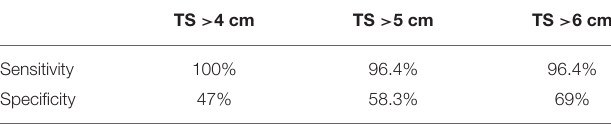
TABLE 4 | Sensitivity and specificity of different tumor size (TS) cutoff in favor of open surgery (vs. non-open surgical approaches).